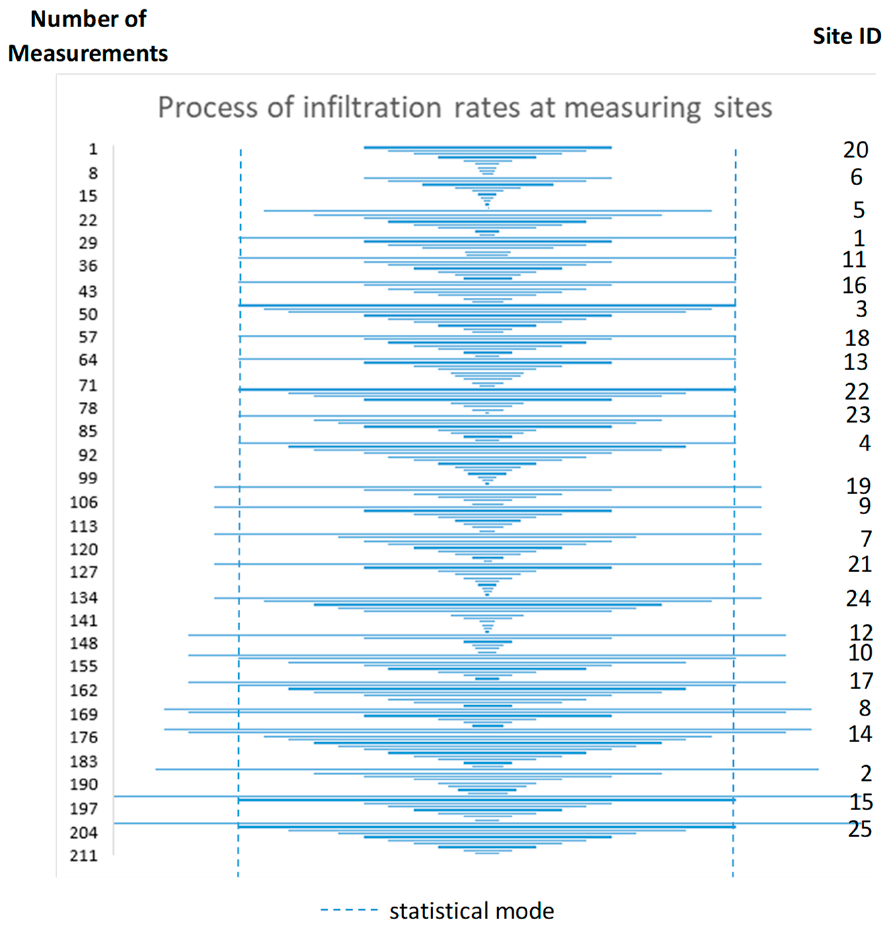
Figure 4. Progress of the process of infiltration rates at measuring stations (number to the left).